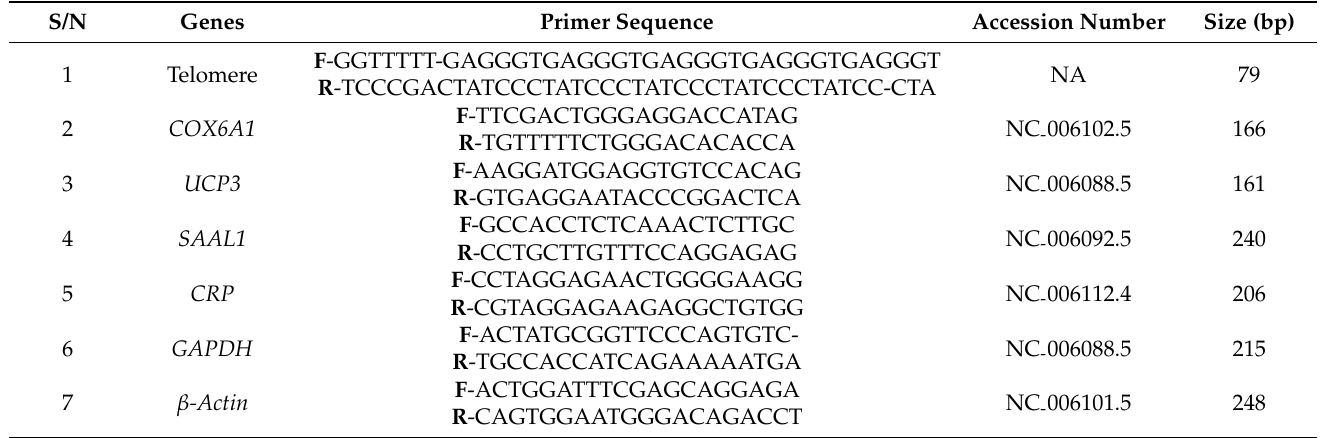
Table 2. Primer sequence for telomere regulatory genes in